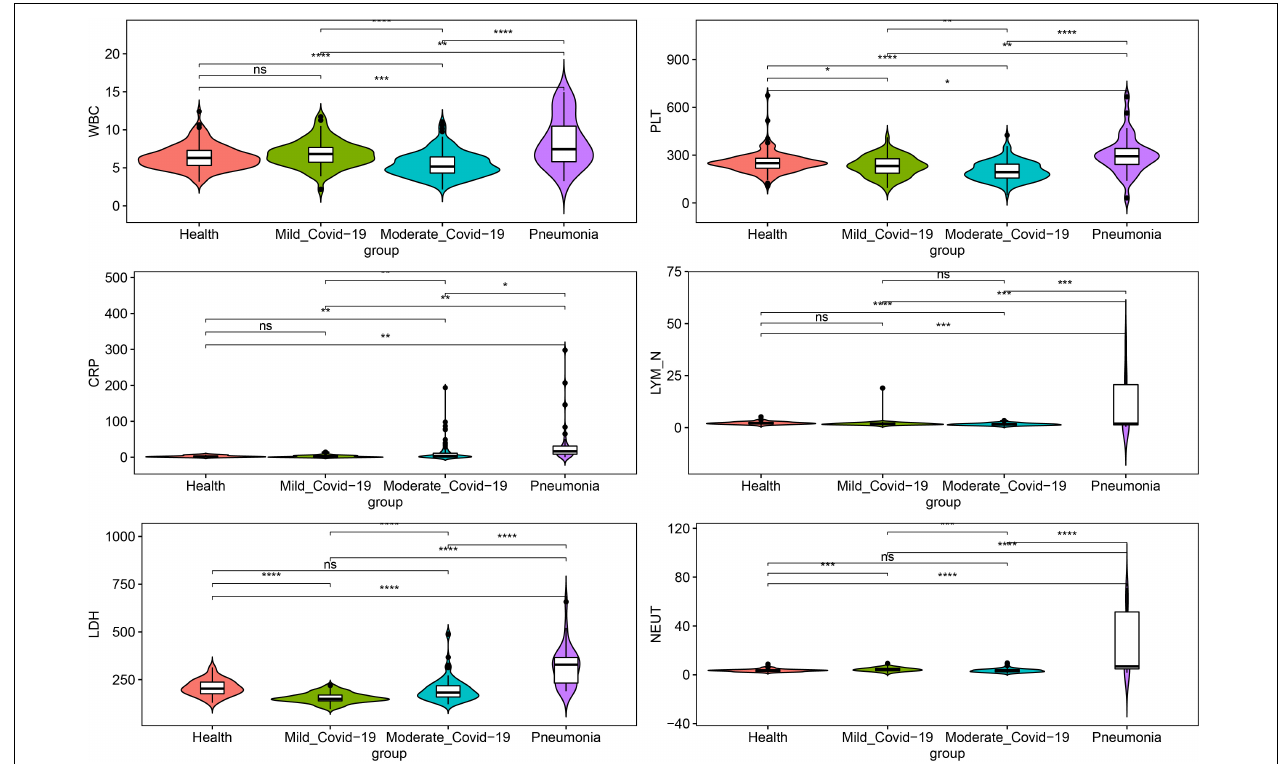
FIGURE 1 | Comparison of six biochemical indices among the healthy, mild COVID-19, moderate COVID-19, and non-COVID-19 pneumonia groups. LDH, lactate dehydrogenase, PLT, platelet count, NEUT, neutrophilic granulocyte count, WBC, white blood cell count, CRP, C-reactive protein, LYM_N, lymphocyte count, Imp_mild, imported mild COVID-19, Imp_moderate, imported moderate COVID-19, Ind_mild domestic mild COVID-19, Ind_moderate domestic moderate COVID-19. ns P > 0.05, * P < 0.05, ** P < 0.01, *** P < 0.001, **** P < 0.0001 (Student’s t -test).